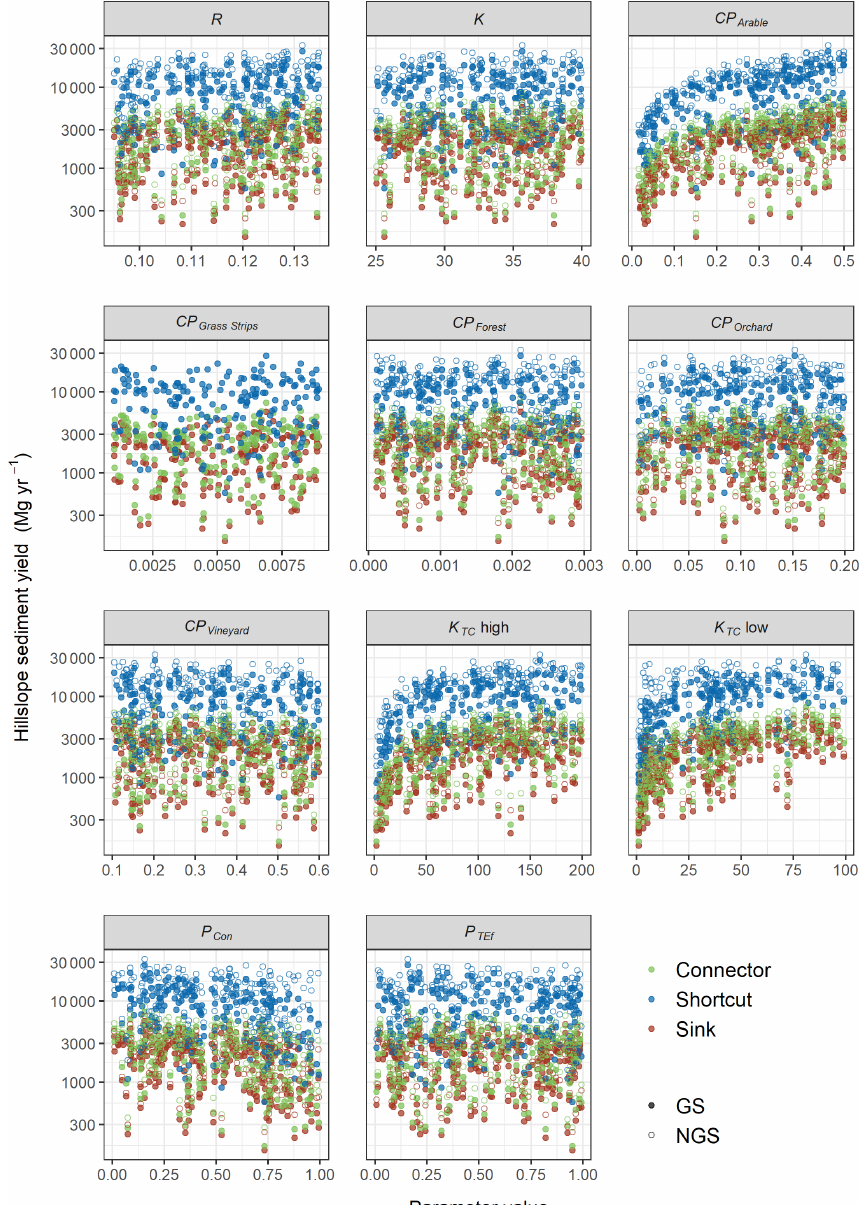
Figure 4. Univariate scatterplots of sampled parameter values. Full circles represent model realisations with the presence of grass buffer strips (GS), and open circles represent the ones without strips (NGS). Colours represent the road connectivity assumptions (i.e. roads as patch connectors, roads as hydraulic shortcuts, and roads as sinks). See Sect. 2.4 for a description of road connectivity